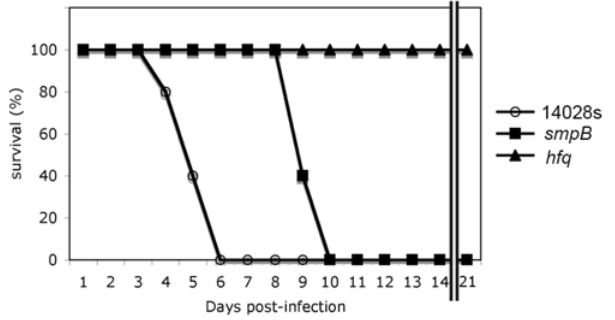
Figure 1. Comparison of survival in mice. Five BALB/c mice were i.p. infected with 200 cfu of Salmonella for each strain; the wild type strain, the D hfq mutant strain and the D smpB mutant strain, and monitored for 21 days. Alive mice were counted and shown in % survival.